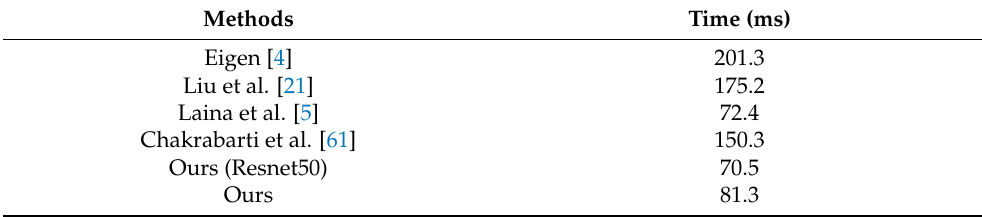
Table 7. Runtime comparison for different methods on NYU